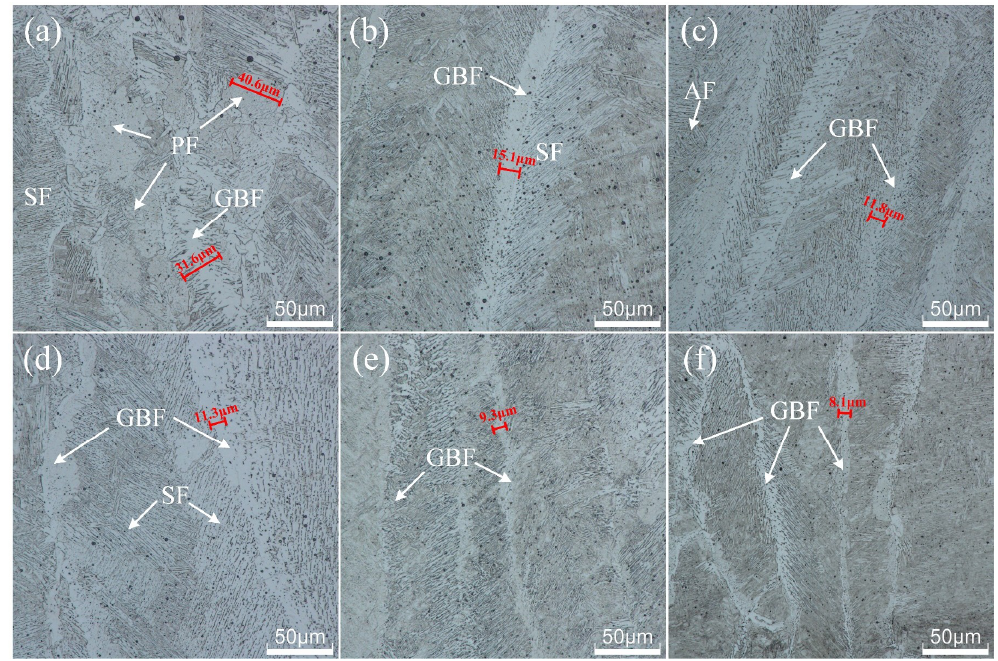
Figure 10. The microstructures of joints in the deposited metal welded at different ultrasonic power: ( a ) without ultrasonic, ( b ) 20%, ( c ) 40%, ( d ) 60%, ( e ) 80%, and ( f ) 100%.